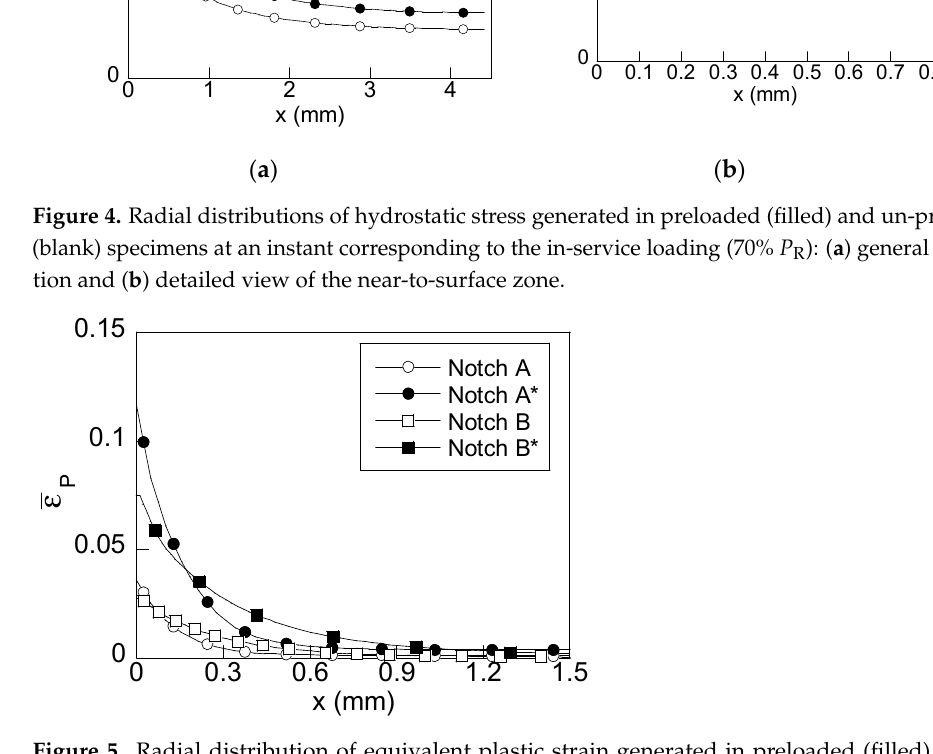
Figure 5. Radial distribution of equivalent plastic strain generated in preloaded (filled) and un-preloaded (blank) specimens at an instant corresponding to the in-service loading (70% P R ).